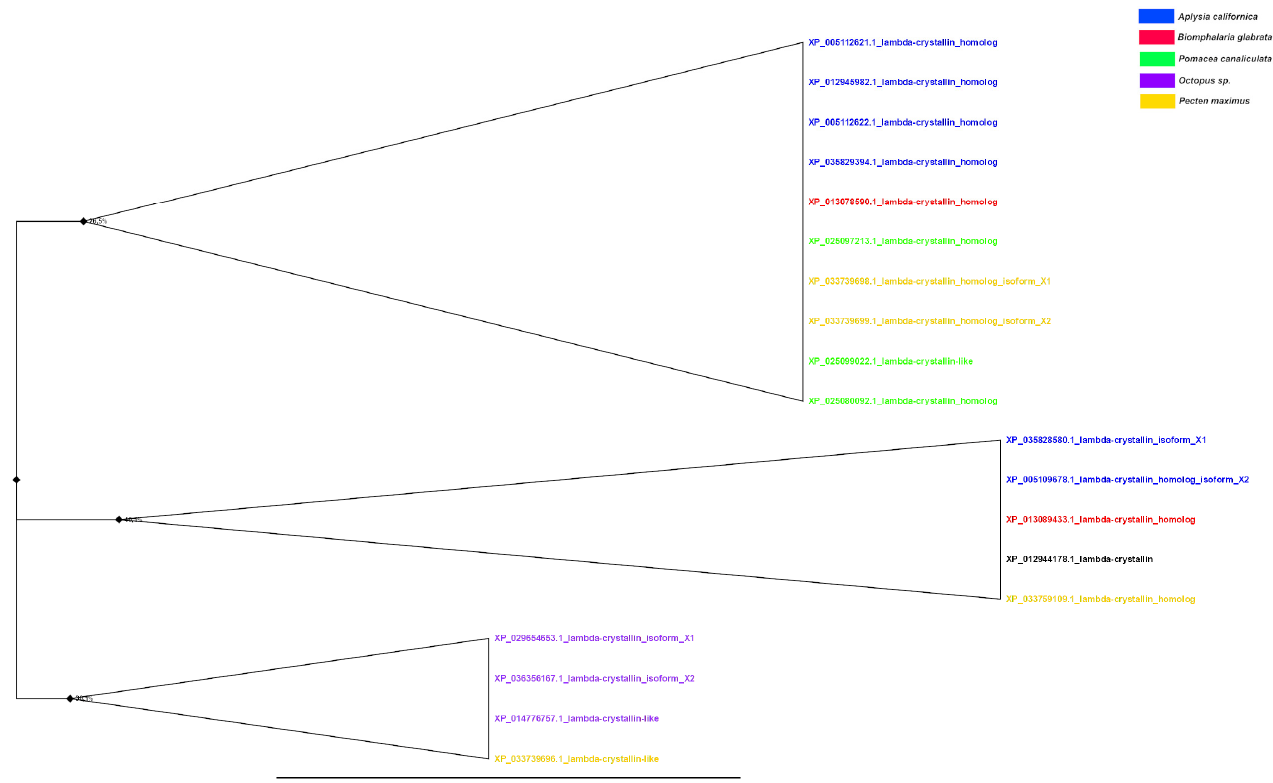
Figure 7. Phylogenetic tree of λ -crystallins of molluscs.